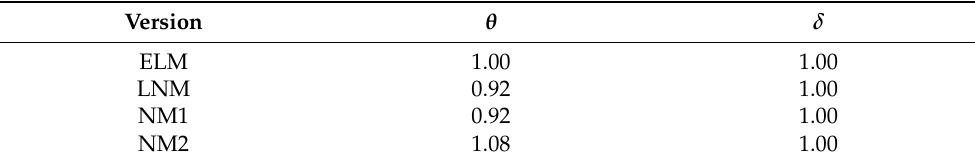
Table 2. Hyperparameter values for named versions of our nonlinear framework (Equation